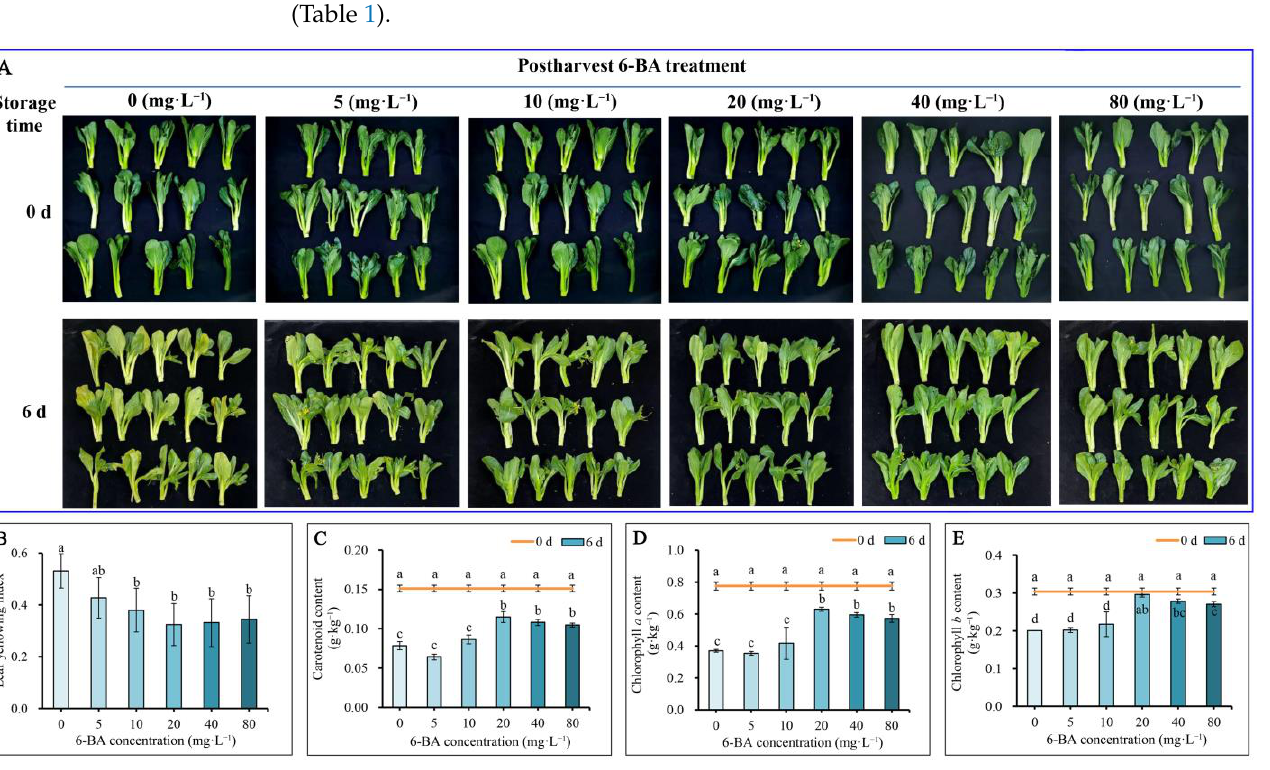
Figure 1. Effects of 6-benzyladenine (6-BA) treatment on appearance quality and changes in pig- ments of Chinese flowering cabbage during storage. The appearance quality of Chinese flowering cabbage with postharvest treatment of 6-BA at various concentrations ( A ). Leaf yellowing index ( B ), carotenoids ( C ), chlorophyll a ( D ), and chlorophyll b ( E ) contents of leaf of Chinese flowering cabbage stored at 25 ◦ C for 6 d in the dark. Each bar indicates the mean ± standard deviation of three biological replicates, and different lowercase letters indicate significant differences between Chinese flowering cabbage under different treatments ( p <